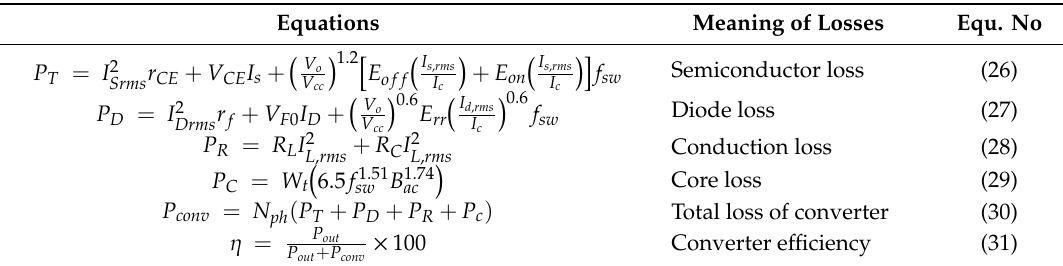
Table 5. Equation for loss estimation of DC-DC converters.